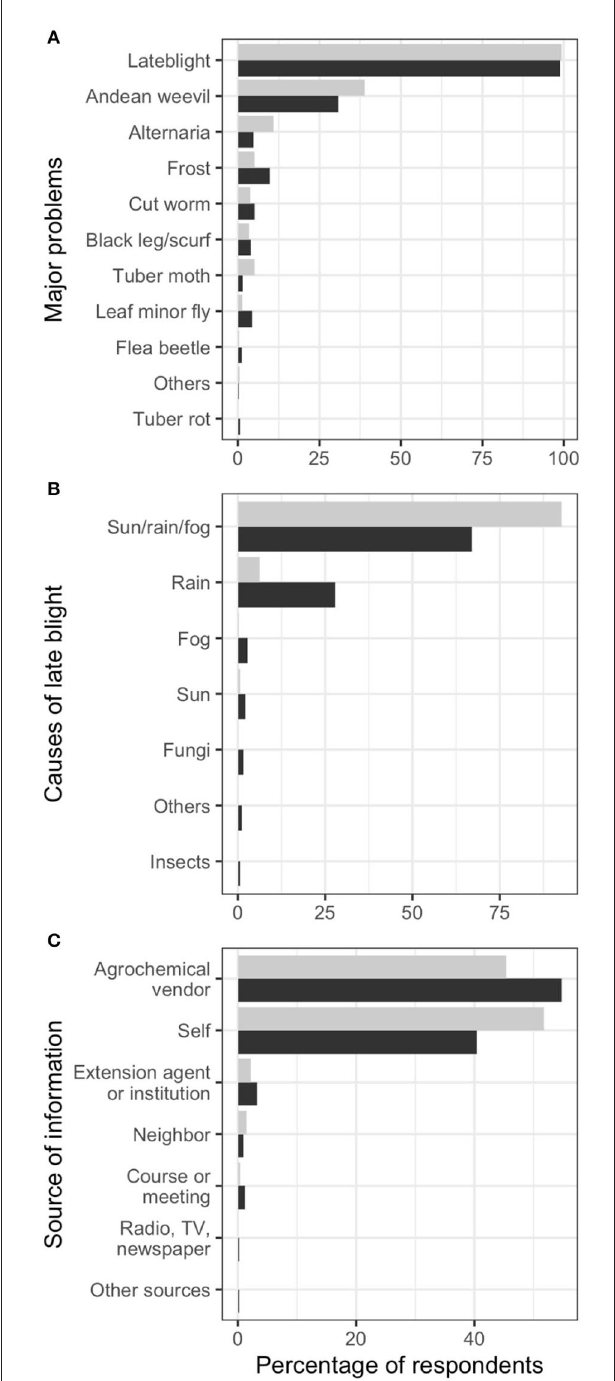
FIGURE 2 | Percentage of respondents choosing specific potato pests and diseases as the primary problem (A) , causes of late blight (B) , and sources of information to control late blight (C) Legend: black, Paucartambo; gray, Ulcumayo. Fisher’s exact test for independence of location and the factor in question was highly significant in all three